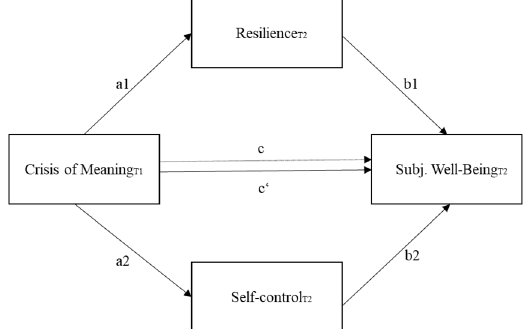
Figure 1. Multiple mediation model illustrating the association between crisis of meaning and subjective well-being via resilience and self-control. The arrow marked with c denotes the total effect and the arrow marked with c’ denotes the direct effect.